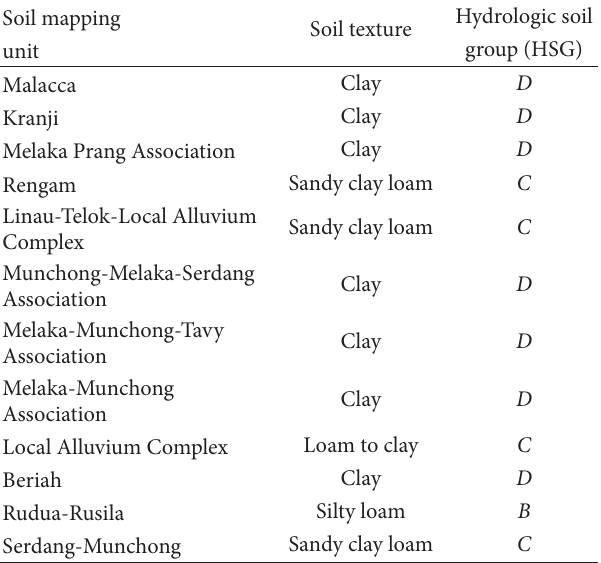
Table 2: Hydrological soil group classification of Melaka. Soil mapping